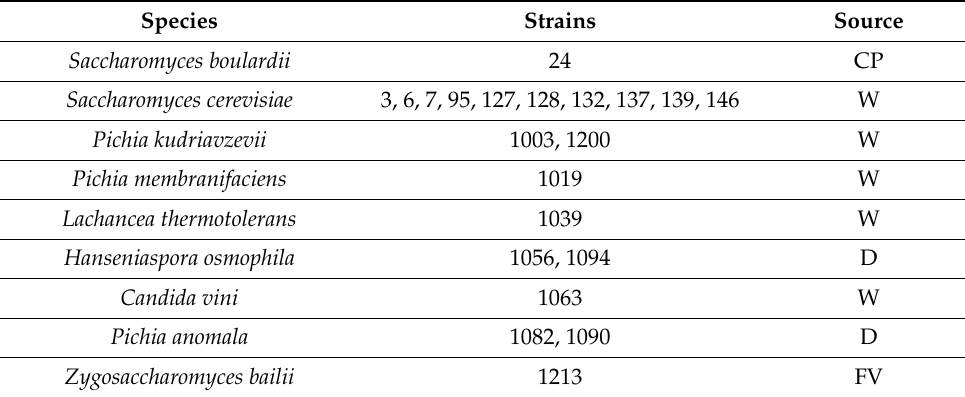
Table 1. Yeast strains and their sources of isolation. Species Strains